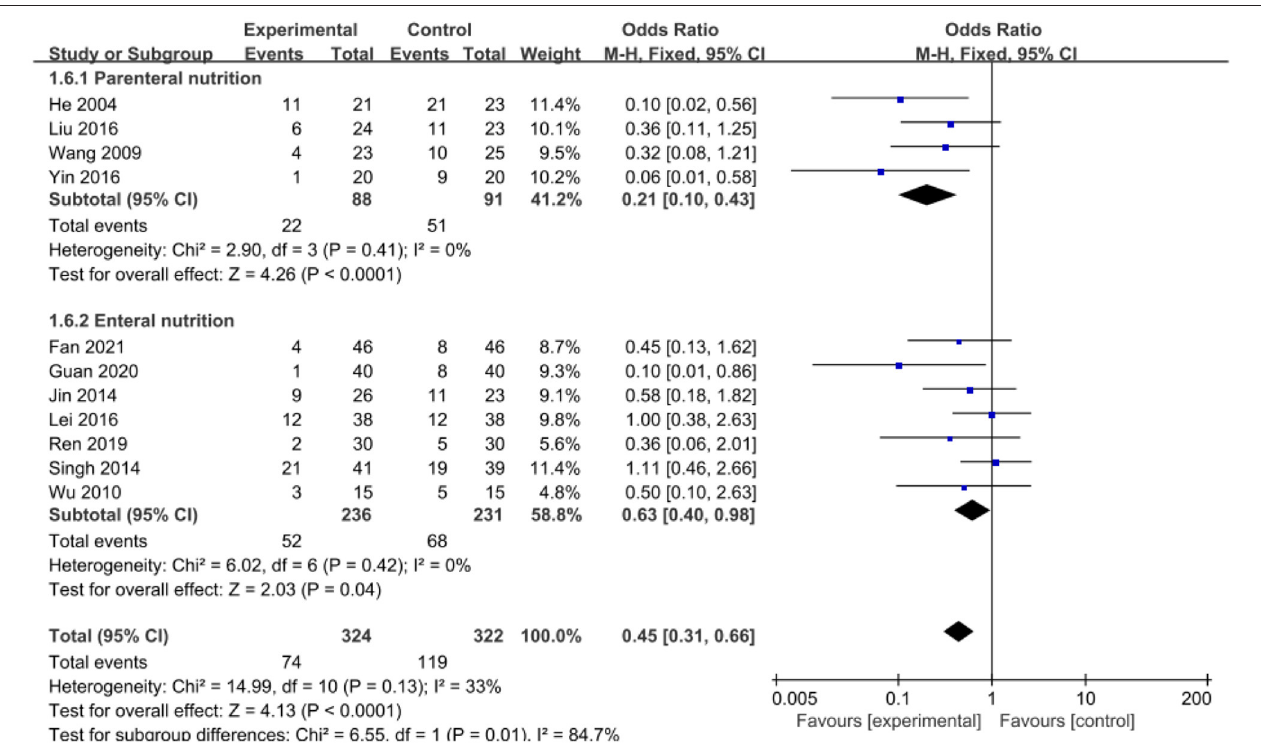
FIGURE 9 | Forest plots of complications associated with experimental group (parenteral or enteral nutrition group supplemented with Gln) vs. control group (conventional nutrition group). I 2 tests and P are the criteria for the heterogeneity test, (cid:7) , pooled odds ratio; — (cid:4) —, odds ratio, and the edges of (cid:7) , 95%